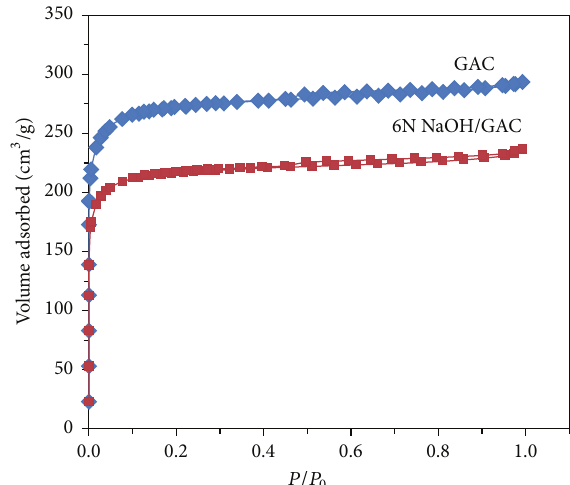
Figure 2: N 2 adsorption-desorption isotherm of GAC and